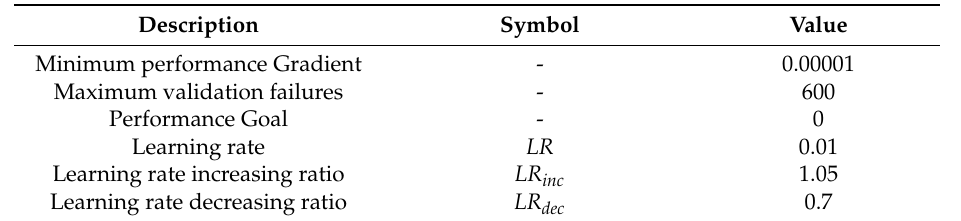
Table 2. Training